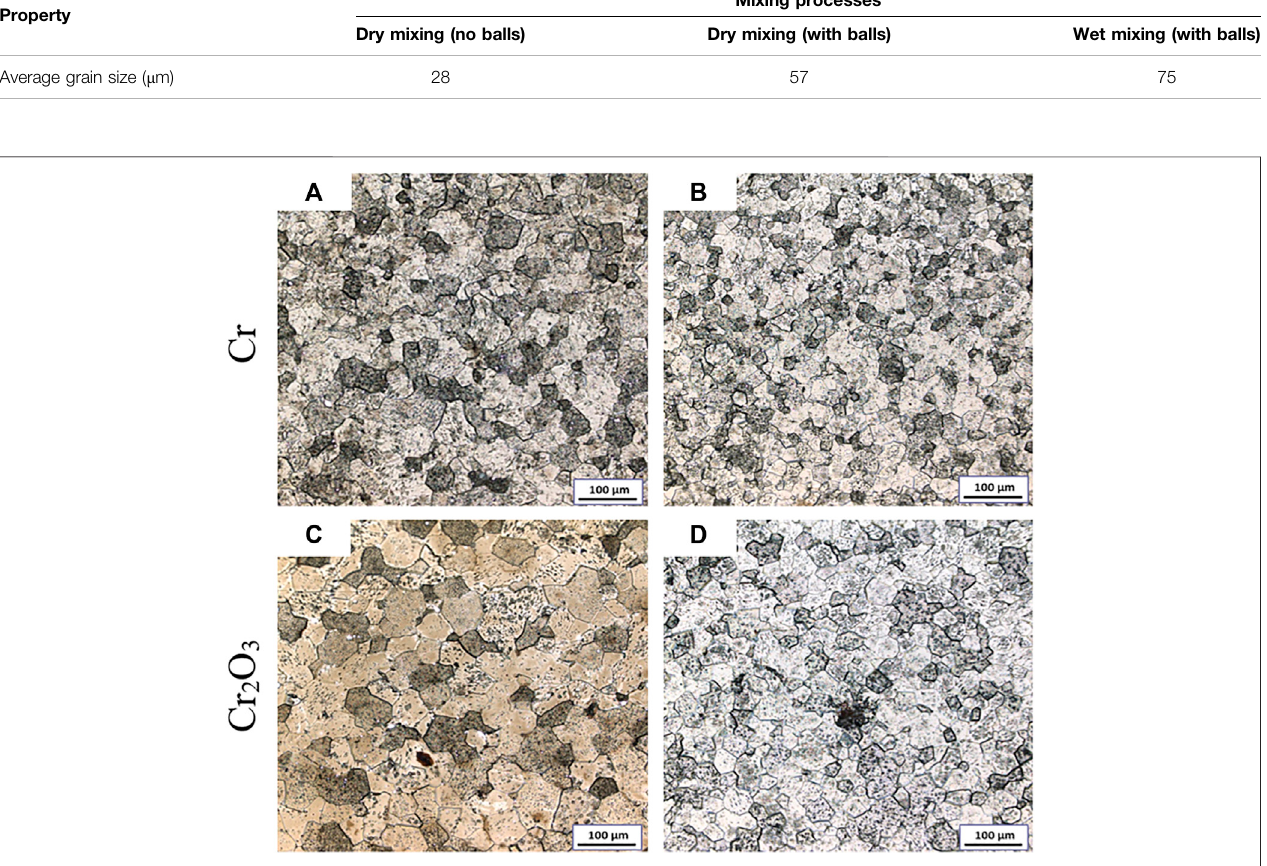
FIGURE3| GrainmorphologiesofCrandCr 2 O 3 dopedUO 2 underdifferentpowderpretreatmentprocesses. (A) Coldpressgranulation; (B) SPSpre-sintering; (C) Cold press granulation; (D) SPS pre-sintering.